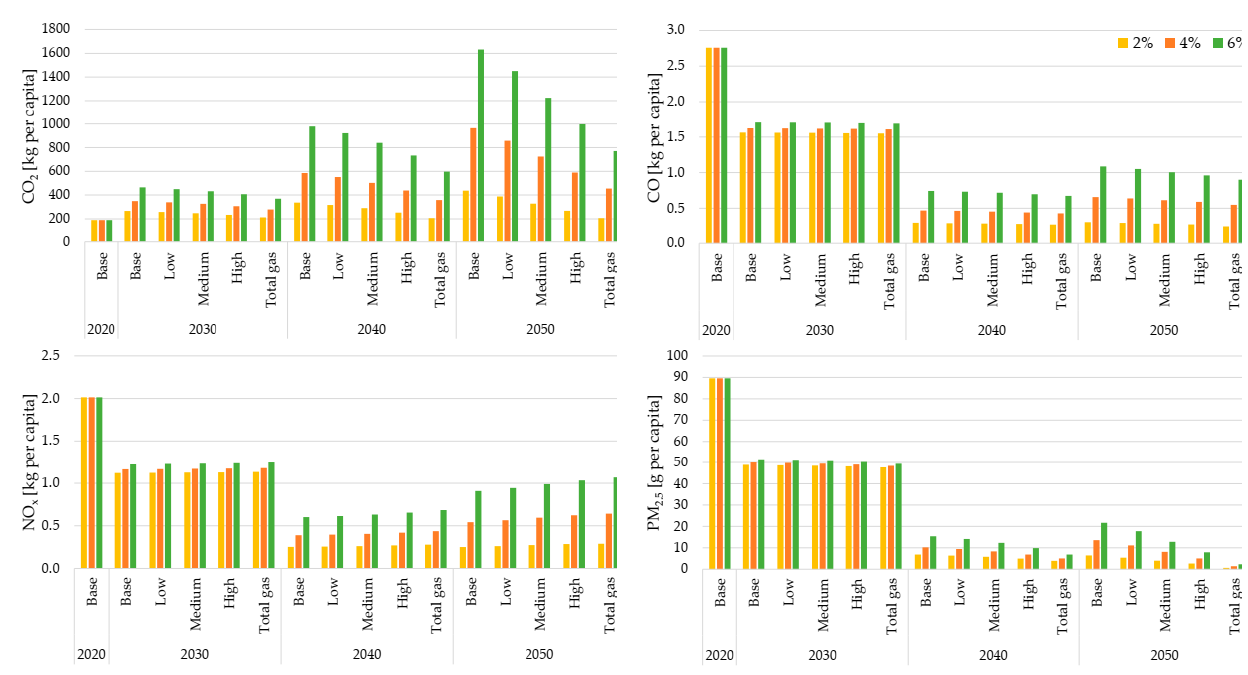
Figure 6. Sensitivity analysis—total emissions per